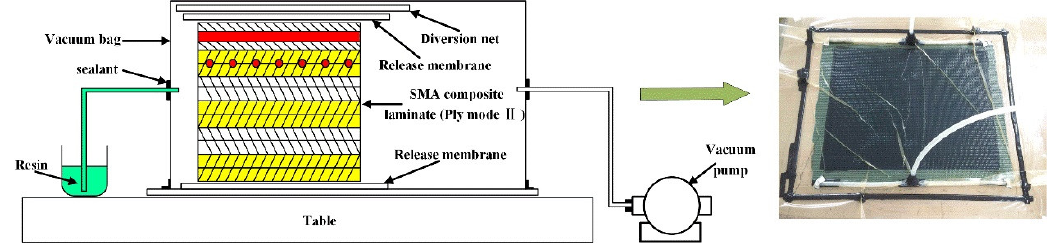
Figure 3. The schematic diagram of the VARI process.